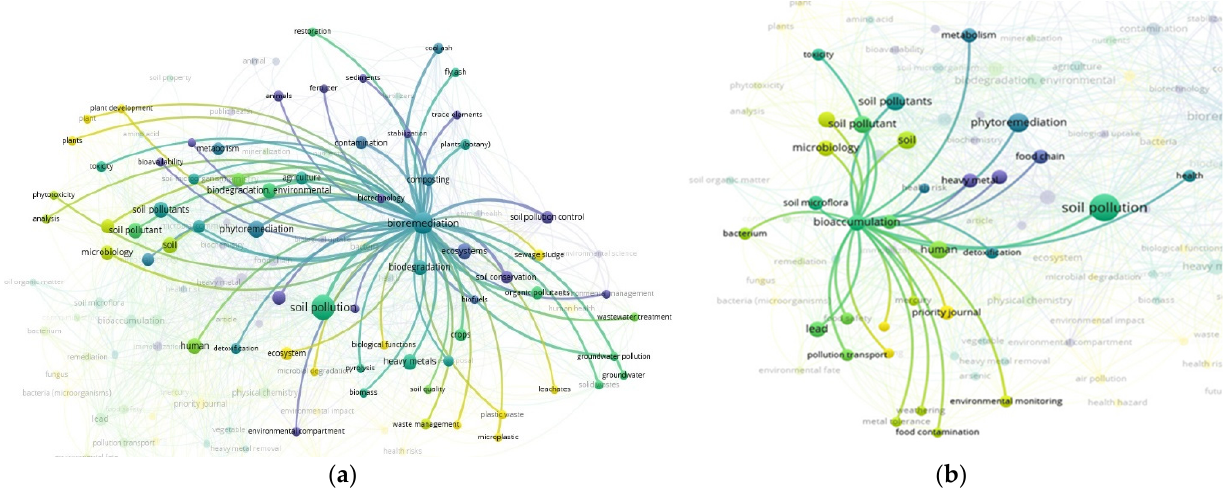
Figure 13. Analyzing Scopus results with the VOSviewer. The bioremediation ( a ) the bioaccumulation ( b ) paradigms.